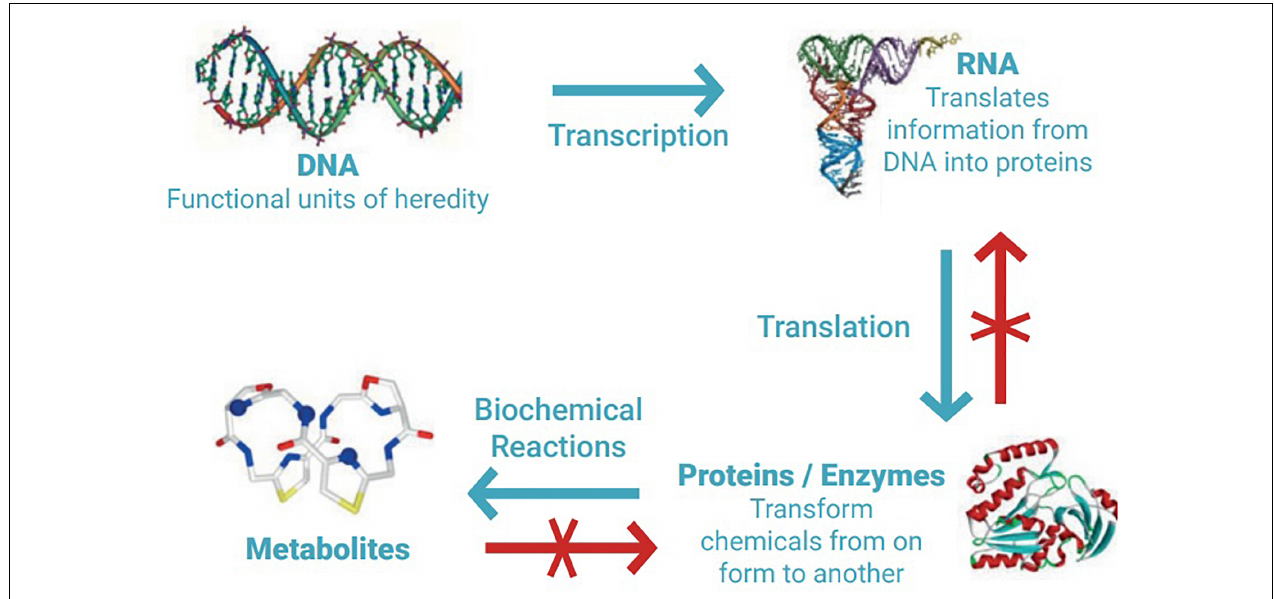
FIGURE 1 | DNA is the cell’s master ‘instruction manual’; segments of the DNA (genes) are read off (transcribed) to build a corresponding piece of RNA, which ultimately helps to create a protein. Proteins are the functional unit of the cell, used for cell repair or to make hormones, for example. By turning one chemical into another, proteins make secondary metabolites, or biochemical derivatives. Biomolecule data cannot be ‘reverse engineered’; knowing a metabolite’s formula or a protein’s sequence is insufficient to predict the sequence of the underlying gene. Figure and caption reproduced with permission of Jeff Marlow (Marlow et al.,